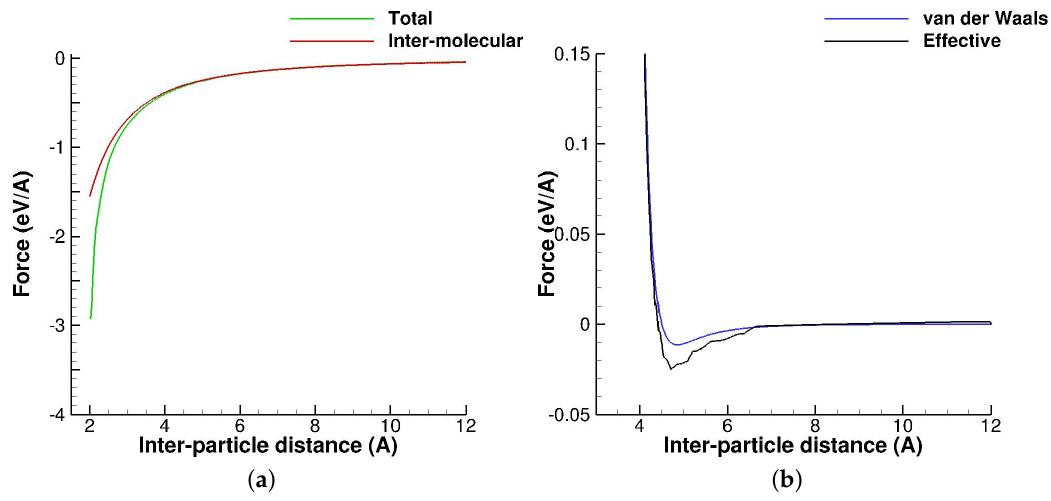
Figure 2. Non-bonded interaction forces between CG sites E1-NN as a function of radial distance. ( a ) The total Coulomb force Equation (8) and inter-molecular Coulomb force Equation (10); ( b ) The van der Waals and the effective Equation (9) non-bonded force.